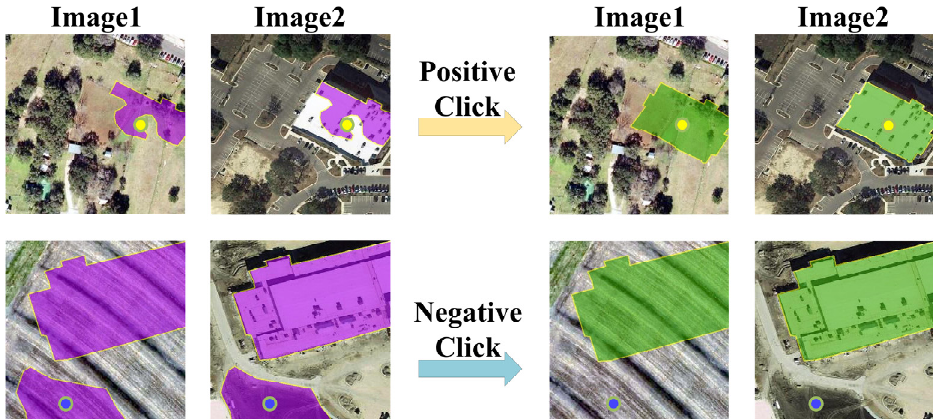
Figure 1. Schematic diagram of interactive change detection and correction.